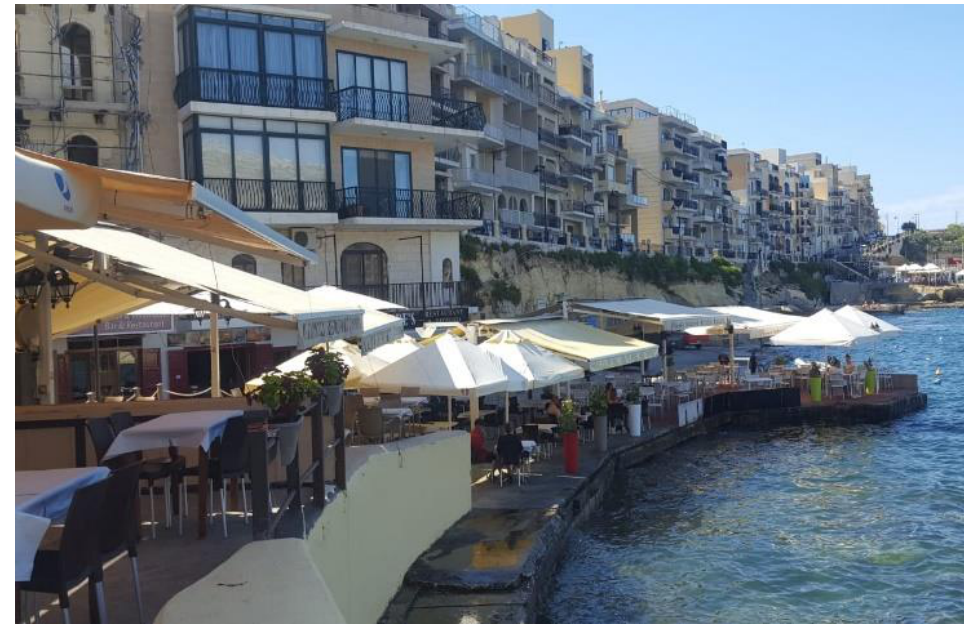
Figure 6 . Marsalforn businesses operating with outdoor seating close to the shore. Figure 6. Marsalforn businesses operating with outdoor seating close to the